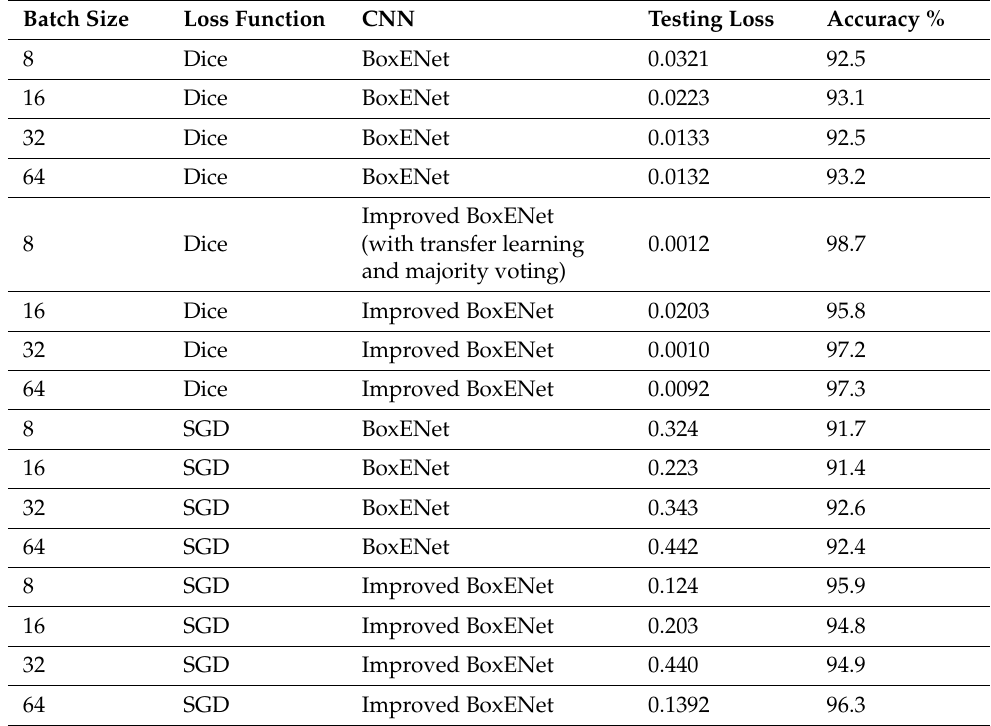
Table 5. Comparative Performance of Original BoxENet and Improved